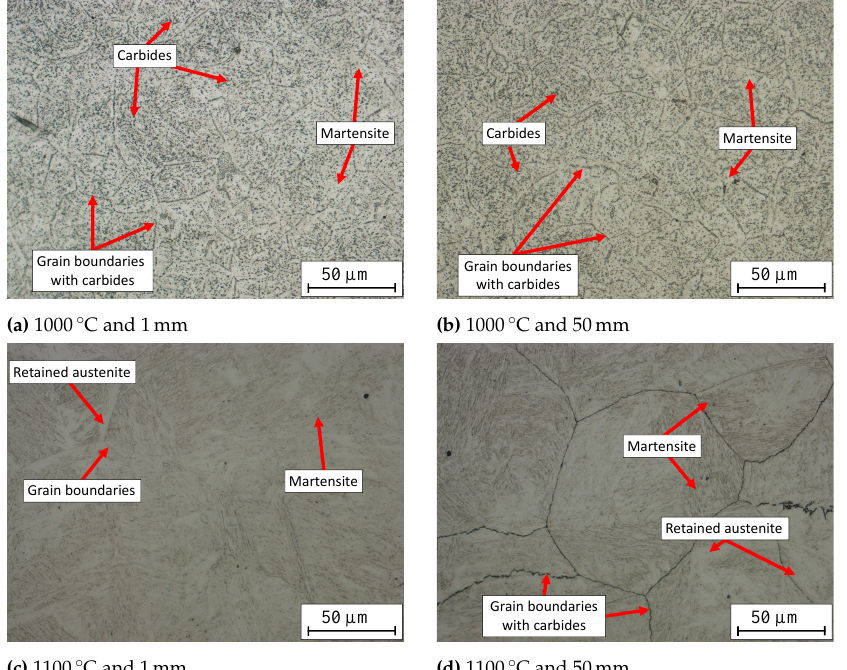
Figure 15. Selected micrographs (optical microscopy) of X30Cr13 as a function of the austenitizing temperature and the distance from the quenched end face and thus the cooling rate: (a) 1000 ◦ C and 1mm, (b) 1000 ◦ C and 50mm, (c) 1100 ◦ C and 1mm, (d) 1100 ◦ C and 50mm. V2A reagent was used as the etchant.